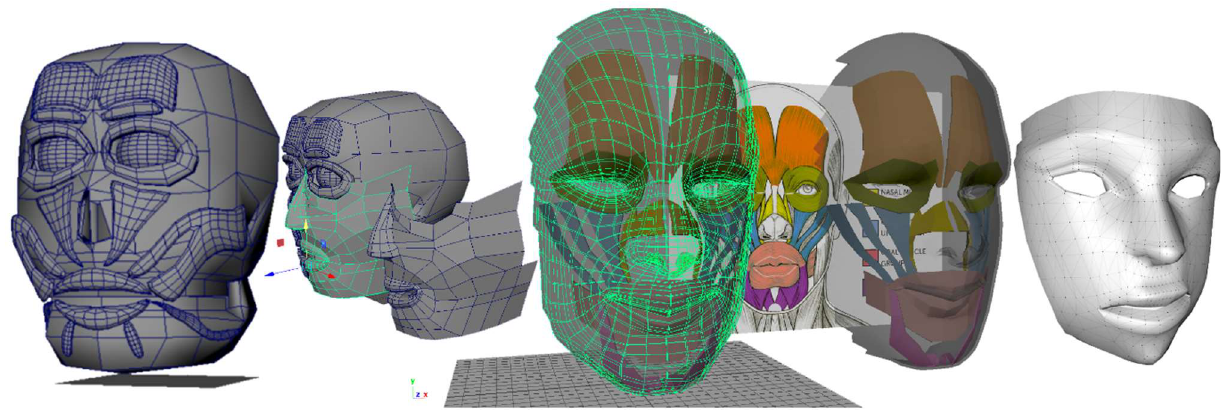
Figure 5. 3D head models created by Nate Durant, Mateusz Jarzembinski and Shahad Albasim, using Autodesk Maya.